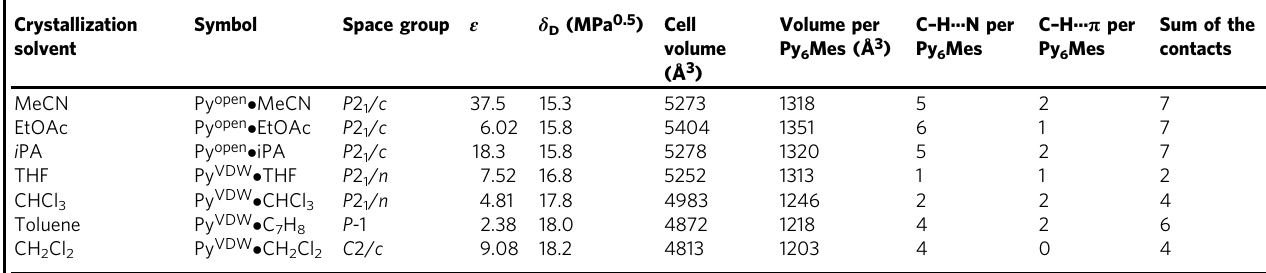
Table 1 Crystallographic information of the polymorphs of Py 6 Mes. Crystallization solvent